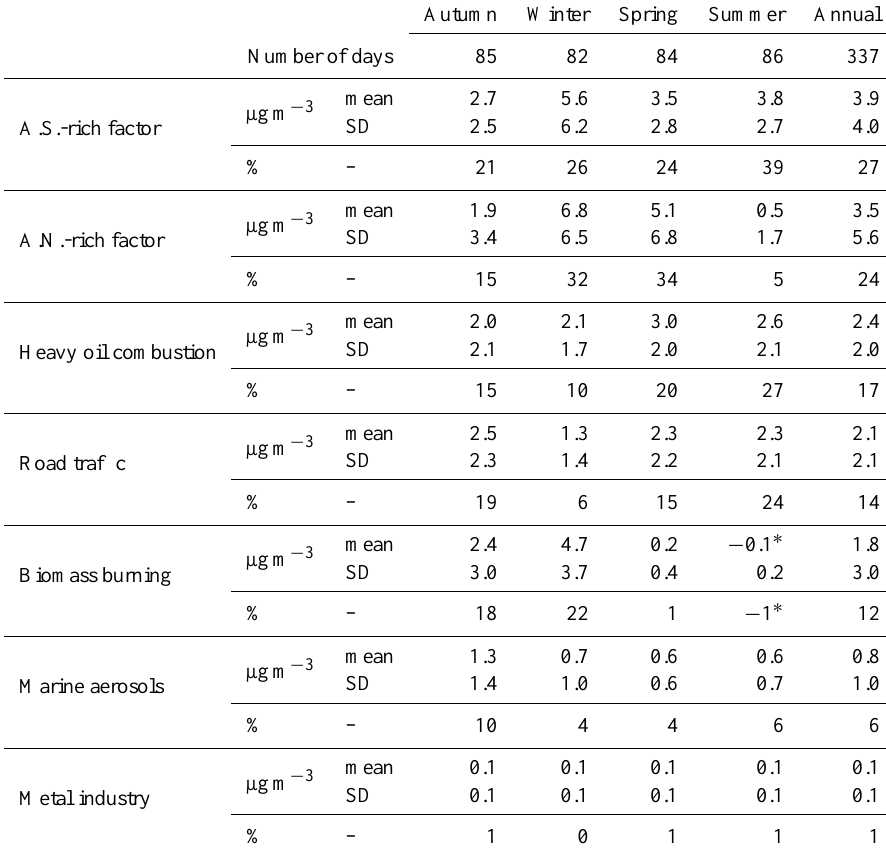
Table 3. Seasonal variations of the absolute concentrations of the sources (µgm − 3 ), and their relative proportions to the averaged PM 2 . 5 mass (%). Legend: SD: standard deviation, A.S.: ammonium sulfate, A.N.: ammonium nitrate. Note: calendar seasons were used, i.e. autumn: from 23 September to 21 December 2009; winter from 22 December 2009 to 20 March 2010; spring: from 21 March to 21 June 2010 and summer: from 11 September to 22 September 2009 plus from 22 June to 10 September 2010; annual: from 11 September 2009 to 10 September 2010. The meaningless negative contribution of the biomass burning source (marked with an asterisk, ∗ ) during summer is due to analytical problems with levoglucosan in September